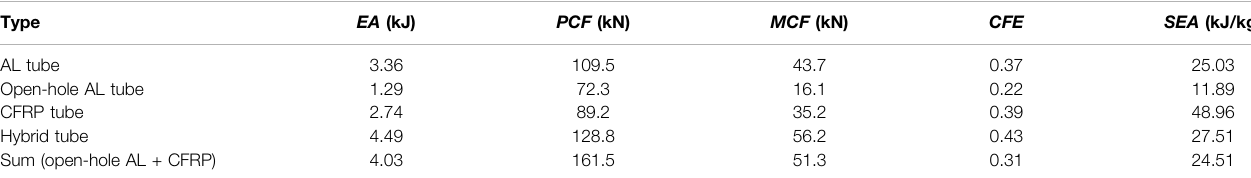
TABLE 2 | Crashworthiness index of all specimens.